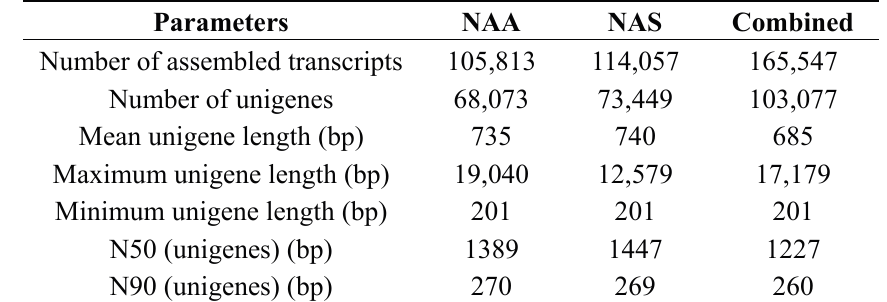
N90 (unigenes) (bp) 270 269 260 N50/N90: the length of unigenes for which the cumulative size is not shorter than 50% or 90% of the total